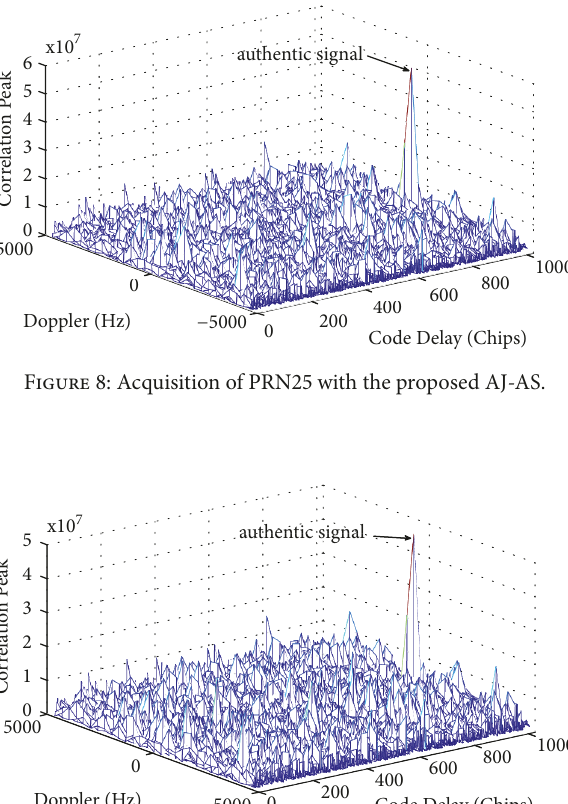
Figure7:AcquisitionofPRN25withantispoofingbasedontracking loop.